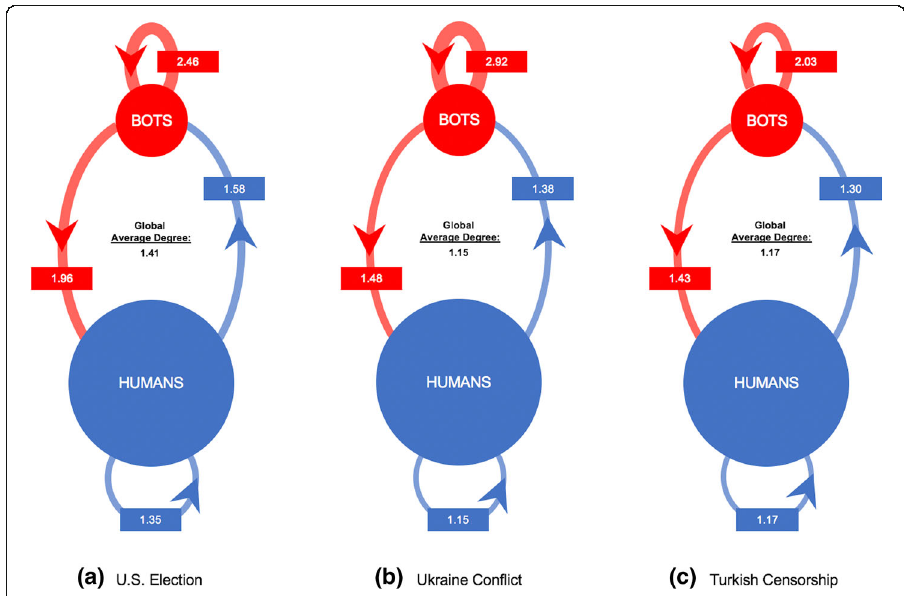
Fig. 3 In-group and cross-group retweet communication average edge weights of human ( blue ) and social bot ( red ) users within each OSN conversation: ( a ) U.S. Election, ( b ) Ukraine Conflict and ( c ) Turkish Censorship. Arrows express communication directionality (e.g. bot directed engagements with human accounts with an average retweet edge weight of 1.96 for the U.S. Election OSN) Degree centrality is the total number of direct edges a node shares with other nodes in a network and does not recognize edge directionality. In a retweet network, degree centrality is synonymous with a Twitter user ’ s popularity in the network. In-degree and out-degree centrality are simply degree centrality that take into account edge directionality. Nodes with higher in-degree centrality receive more directional edge